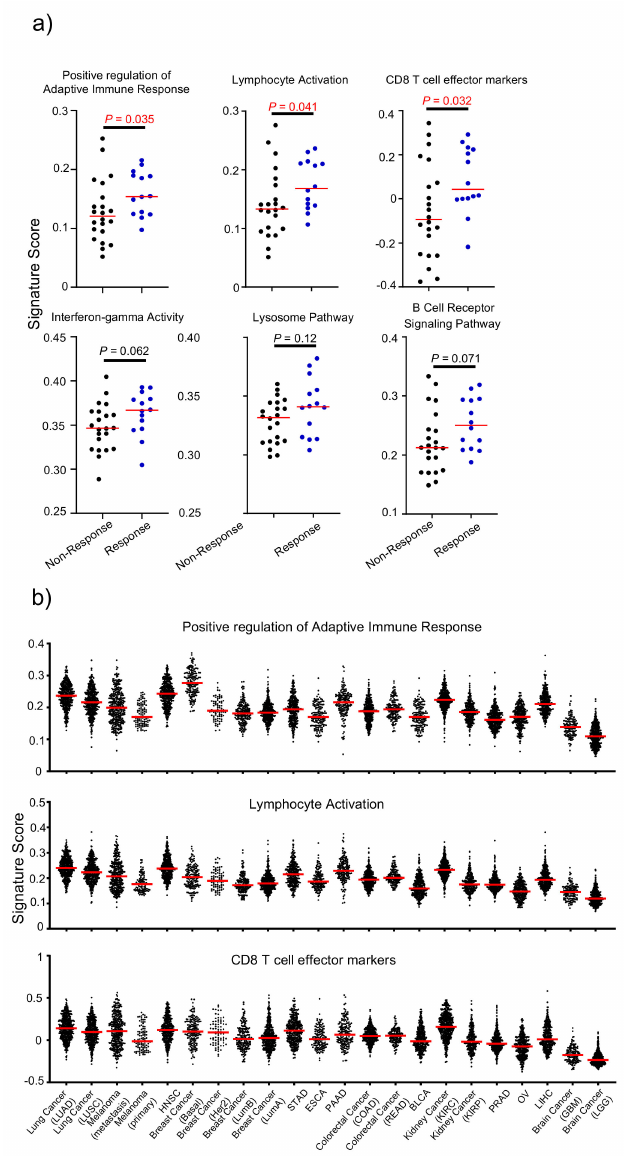
Figure 4. Using immunological signature gene scores validated from the CTLA-4 response database to rank human cancer. ( a ) Distribution plot of the immunological signature gene score change between anti-CTLA-4 therapy responder and non-responder cancer tissues. ( b ) Distribution plot showing three immunological scores of 7279 independent samples from 22 types of human cancer. Those parameters that are significantly associated with CTLA-4 response in ( a ) were chosen to rank the 22 cancer types in ( b